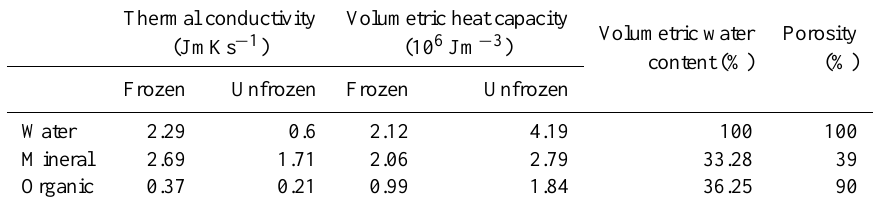
Table 1. The thermal conductivity, volumetric heat capacity, volumetric water content, and porosity used in idealized runs for water, mineral soils, and organic